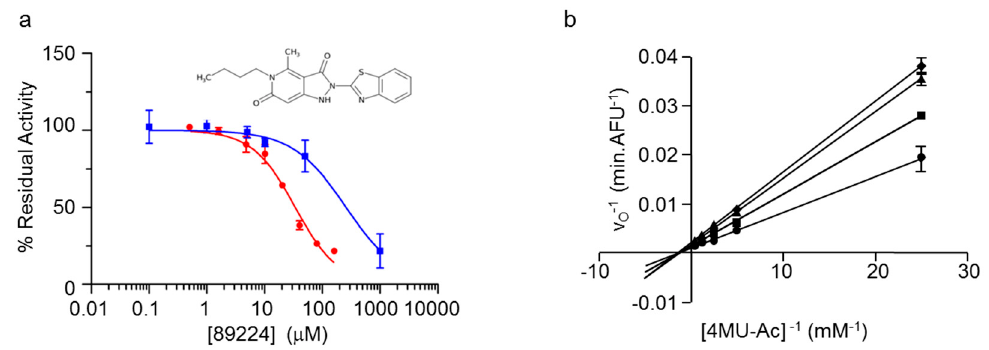
Figure 4. Inhibition of Ng PatB by compound 89224. ( a ) Determination of IC 50 value. ( b ) Determination of the mode of reversible inhibition and K i value. Double reciprocal plot of initial velocity vs . substrate concentration in the presence of ( (cid:8) ) 0 µ M, ( (cid:4) ) 25 µ M, ( (cid:78) ) 75 µ M, and ( (cid:7) ) 125 µ M compound 89224. Error bars denote standard deviation ( n = 3).